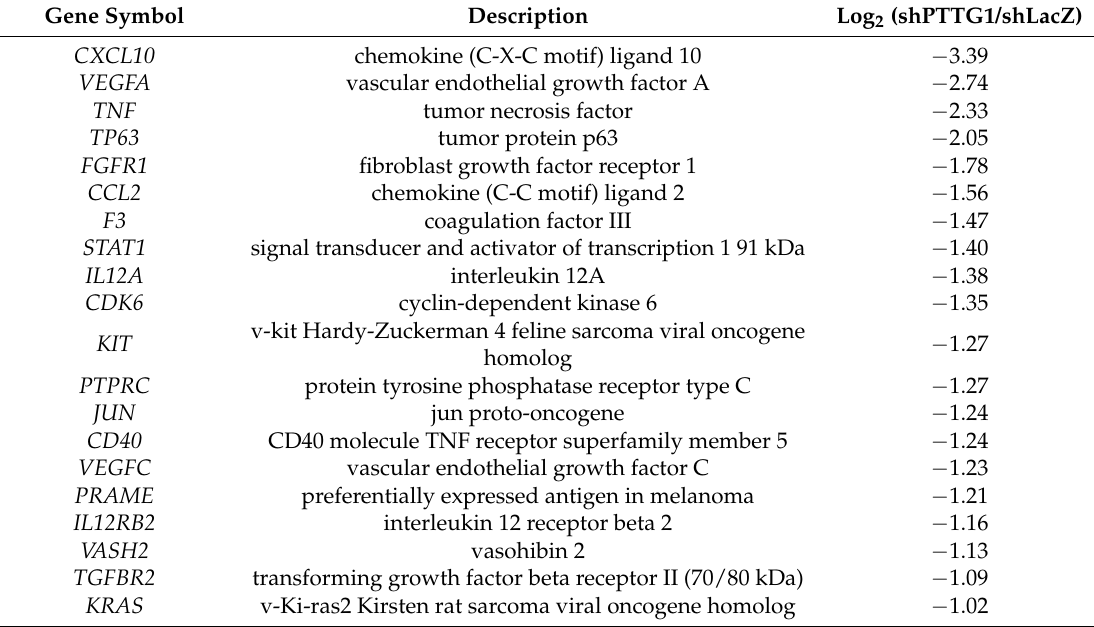
Table 1. Genes associated with the positive regulation of cell-proliferation process categories based on biological process Gene Ontology terms that are down-regulated in PTTG1-knockdown cells. Gene Symbol Description Log 2 (shPTTG1/shLacZ) CXCL10 chemokine (C-X-C motif) ligand 10 − 3.39 VEGFA vascular endothelial growth factor A − 2.74